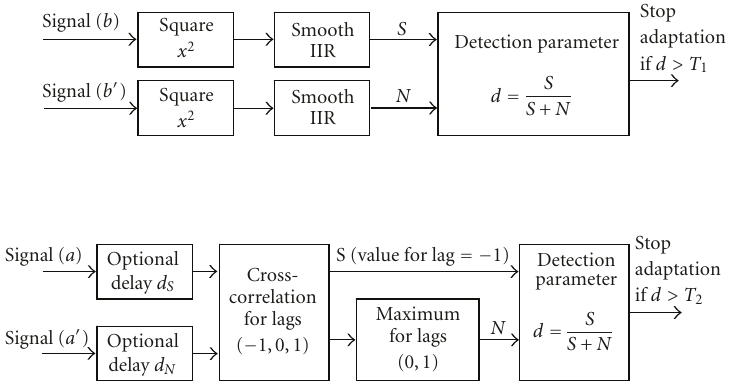
Figure 2: Two target signal detection schemes: top: delta-delta-algorithm. Bottom: multicorrelation algorithm.